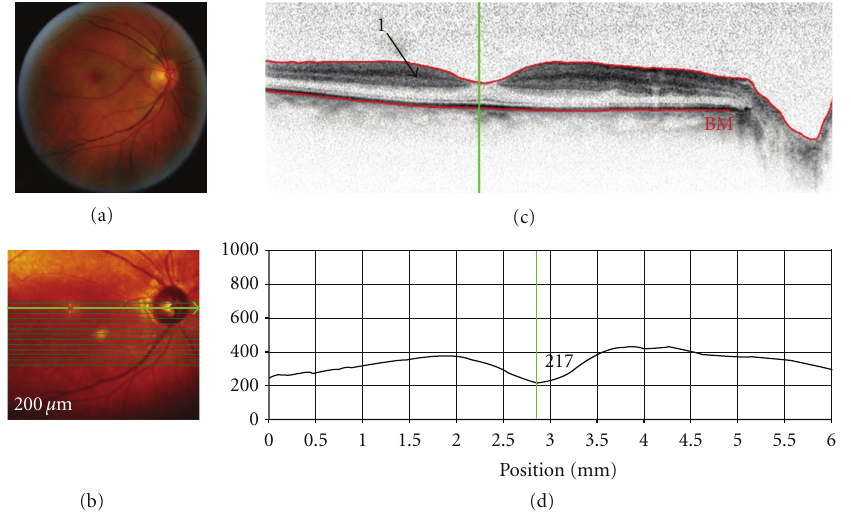
Figure 4: SD-OCT of a patient with central retinal artery occlusion (OD). Scan parameters: infrared scan angle 30 ◦ ; OCT scan angle 30 ◦ ; pattern size 30 ◦ × 10 ◦ , 13 sections (243 µ m between B-scans). (a) The conventional fundus camera image revealed a classic “cherry red spot” and white infarctions (ischemic areas) along the major vessel arcades and around the macula. (b) SD-OCT en-face image centered approximately 2 ◦ below the fovea. The green arrow shows the position of the scan line used to generate the cross-sectional retinal OCT image (i.e., (c)). (c) The cross-sectional retinal image showed a thickening and increased reflectance (arrow “1”) of the inner retinal layers. (d) The cross-sectional retinal thickness profile revealed increased retinal thickness that was especially apparent as an exaggerated foveal pit (indicating swelling of the parafoveal